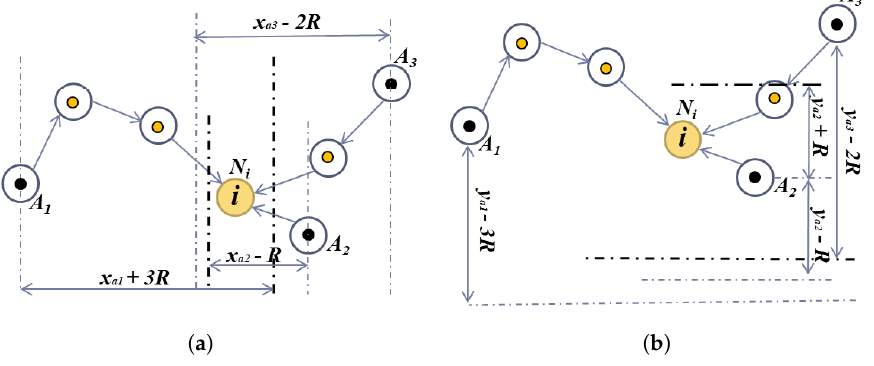
Figure 3. Bounding box method: search space of unknown node. ( a ) ( x − , x + ) coordinates of possible zone of node i. ( b ) ( y − , y + ) coordinates of possible zone of node